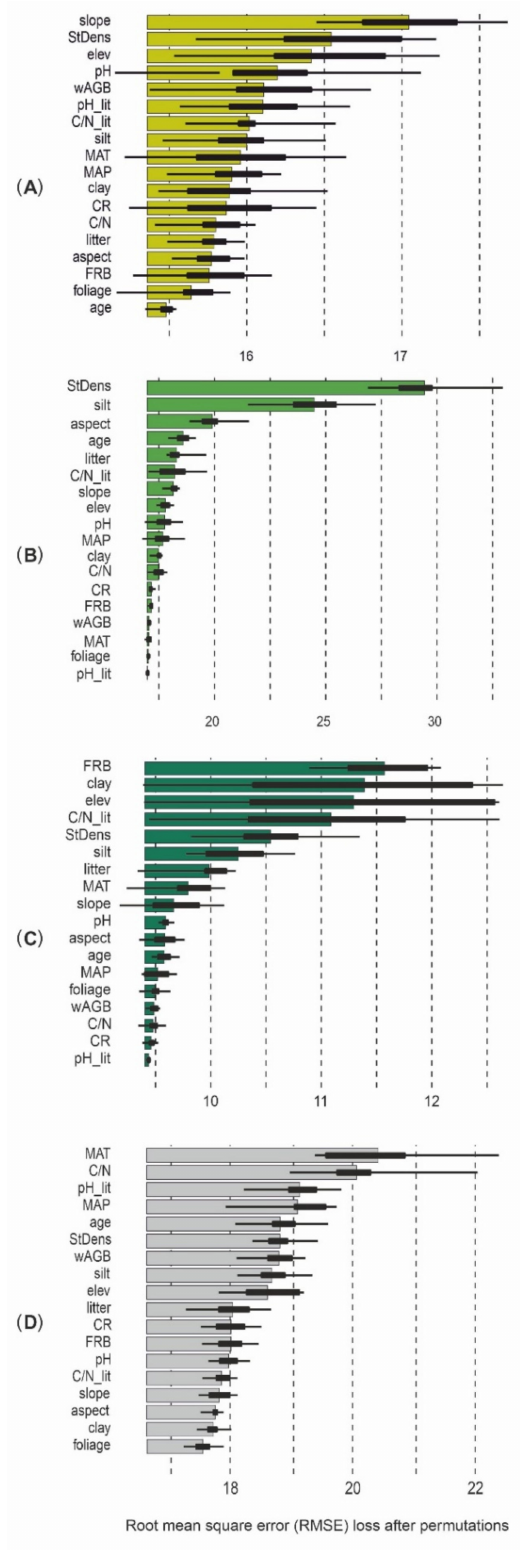
Figure 5. Importance of variables in SOM stock models for beech ( A ), spruce ( B ), fir ( C ) forest and all plots ( D ). This importance is expressed by loss-drop in RMSE when a given variable is perturbed. Abbreviations—see explanation in Table